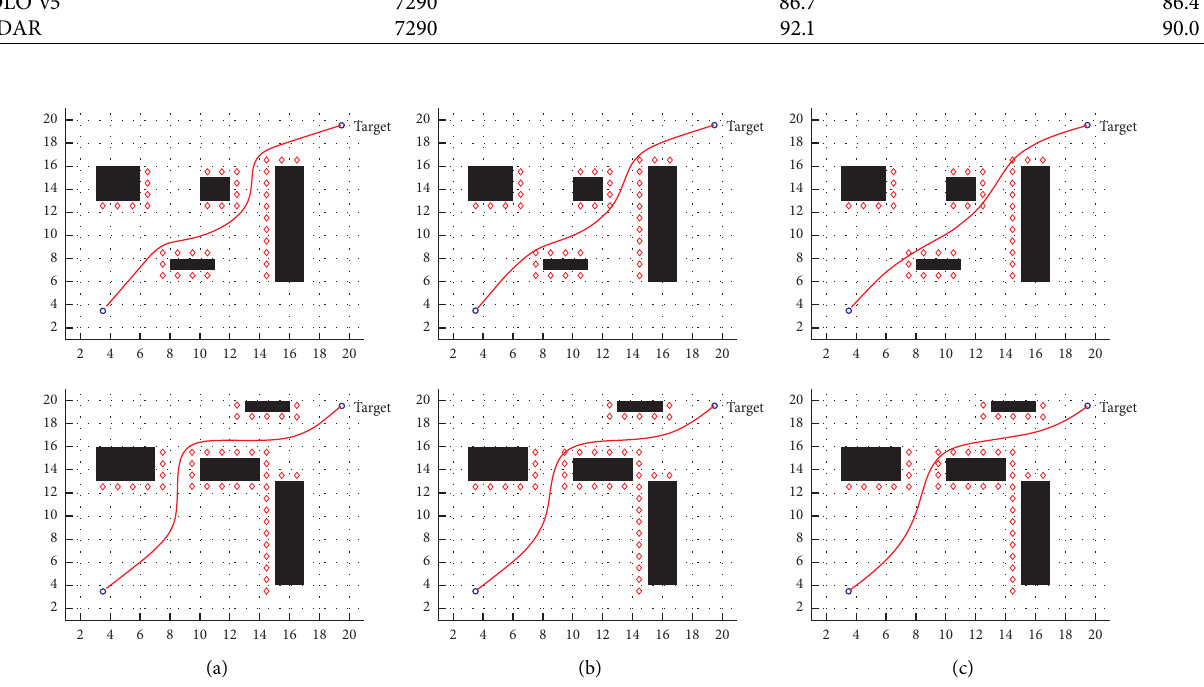
Figure 18: Determination of optimal control node distance s . (a) s � 0.4, (b) s � 0.8, and (c) s � 1.5.